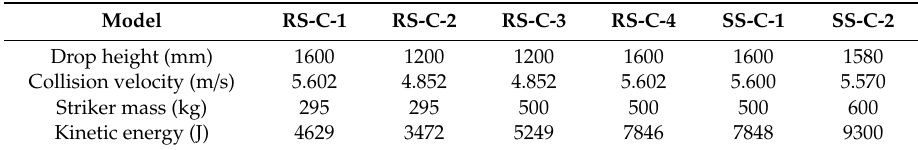
Table 3. Impact test conditions for each